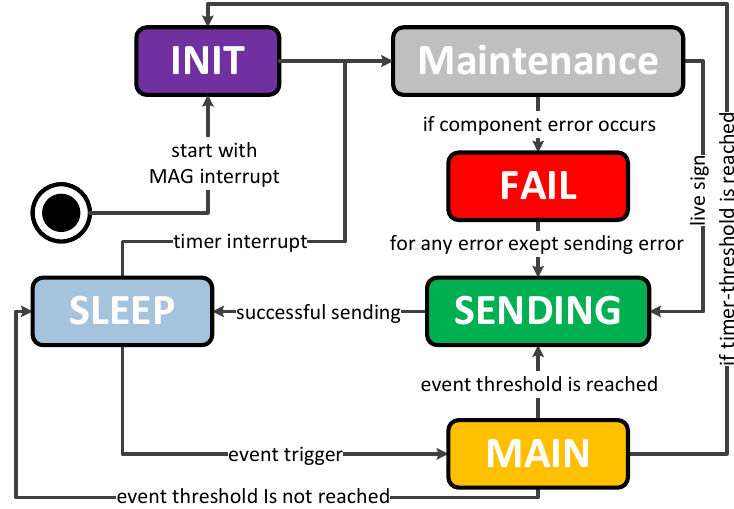
Figure 8. Current INBED wearable state chart